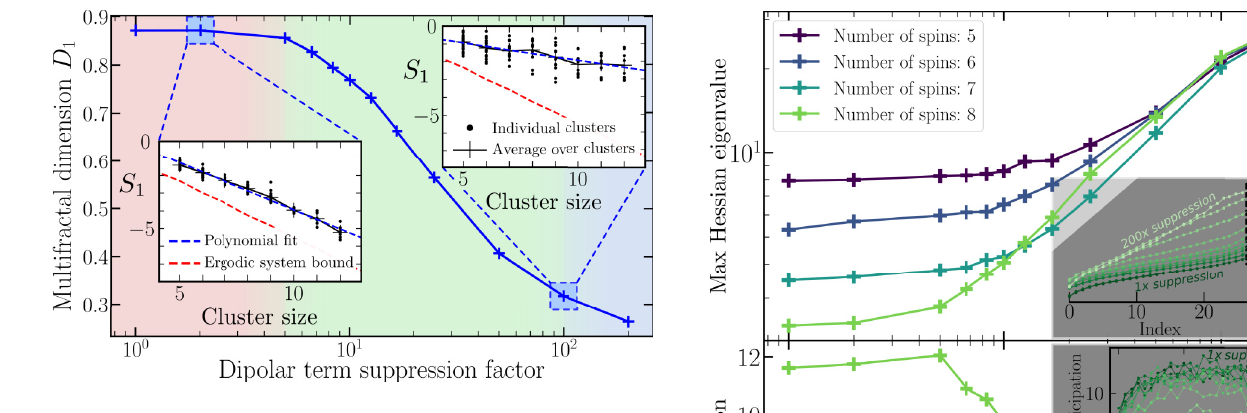
FIG. 6. Plot of the multifractal dimension of small clusters of spins in the ubiquitin molecule as the dipolar term is suppressed in a background 23.5-T field. Points in the main plot are extracted from a linear fit of the mean participation entropy of the different clusters as a function of the system size, as demonstrated in the two insets for suppression factors 2 and 100. From these fits, the multifractal dimension can be estimated. The coloring of the plot indicates the expected quantum and classical learnability of the system as the dipolar term is suppressed, corresponding to the different regions in Fig. 1.